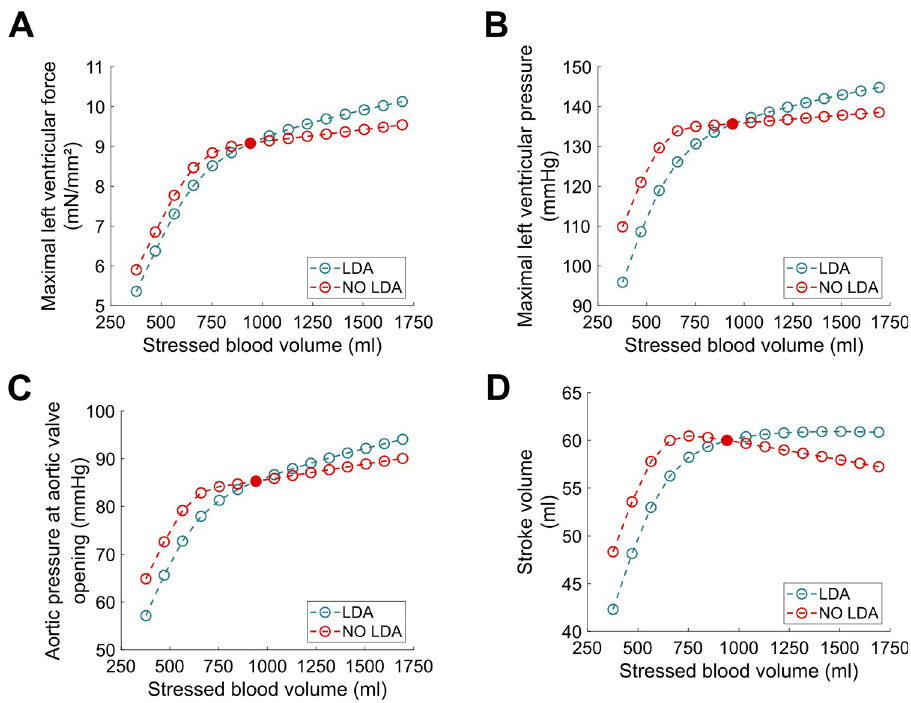
Fig 13. A. Maximal left ventricular force with (blue curve) and without (red curve) LDA. B. Maximal left ventricular pressure with (blue curve) and without (red curve) LDA. C. Afterload with (blue curve) and without (red curve) LDA. D. Stroke volume with (blue curve) and without (red curve)